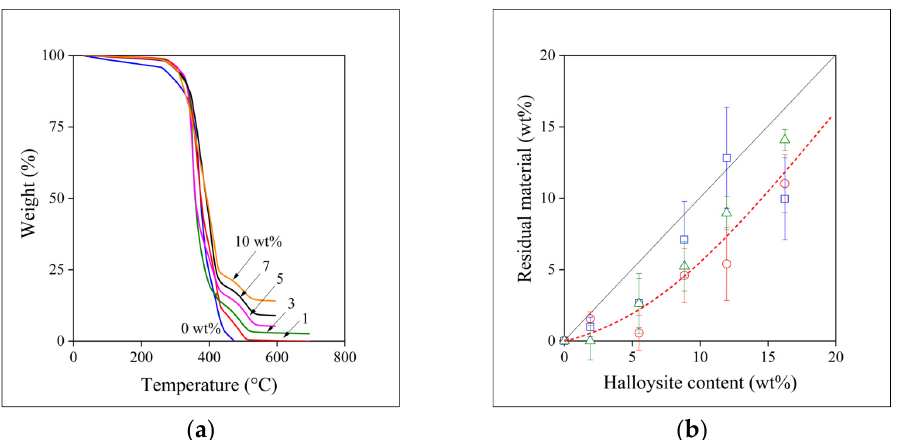
Figure 1. Determination of the halloysite content of PCL/halloysite composites by TGA measure- ments. ( a ) Weight loss of the material during the measurement. Halloysite content increases from bottom to top. ( b ) Correlation between the nominal and the measured (residual material) halloysite content of the composites. Symbols: ( ) film, ( (cid:3) ) compressed, ( (cid:52) ) melt mixed. The straight line indicates the equality of the two quantities.